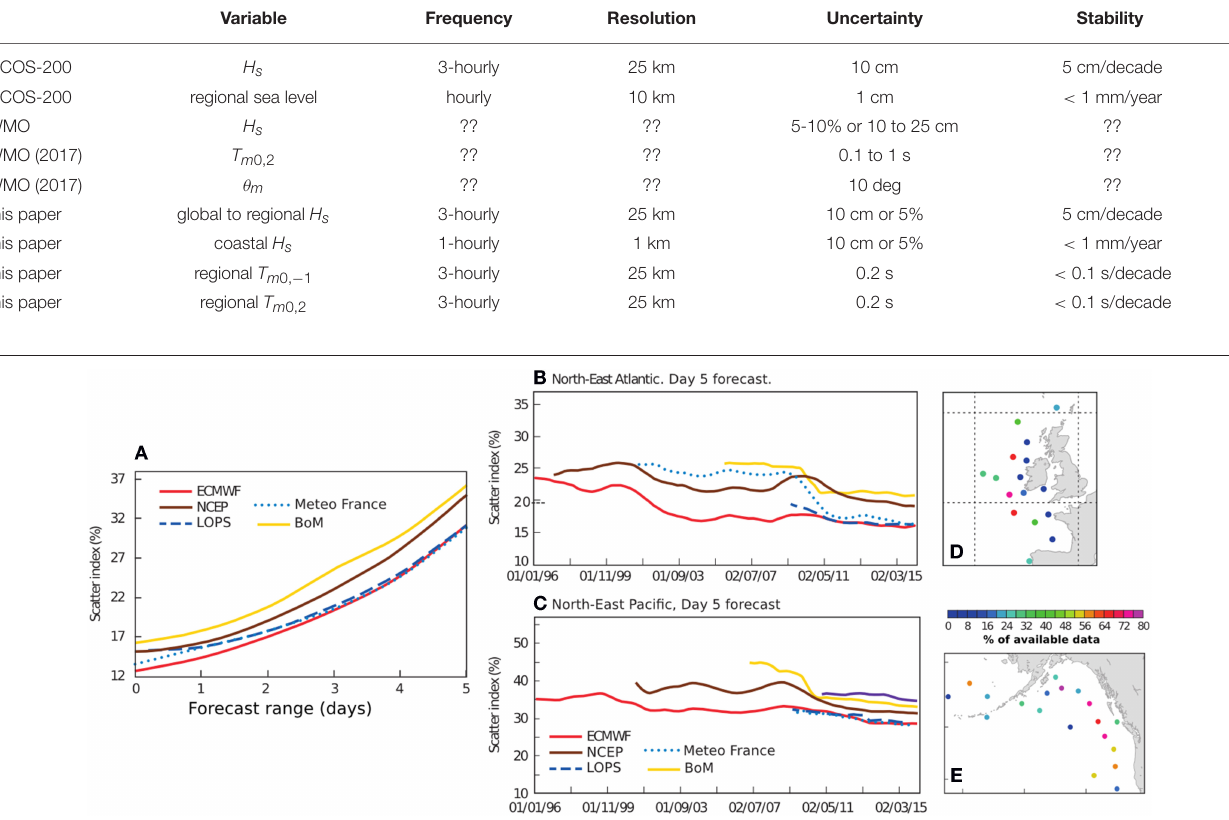
FIGURE 3 | (A) Scatter index for H s from 5 numerical wave forecasting systems against a selection of mostly Northern Hemisphere wave buoys, as a function of forecast range, for the months of September 2015 to August 2016. These forecasts are produced by ECMWF (Reading, UK, with reanalysis available as ERA5), NOAA/NCEP (MD, USA), Meteo-France (Toulouse, France, now available as part of the Copernicus Marine Environment Monitoring Service, marine.copernicus.eu), the Bureau of Meteorology (Melbourne, Australia) and LOPS (Brest, France, available in hindcast at ftp://ftp.ifremer.fr/ifremer/ww3/HINDCAST/). Focusing on